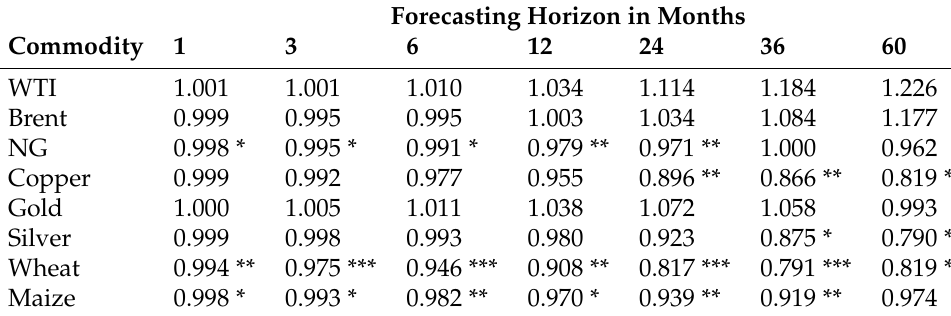
Table 3. RMSFE ratio for real commodity price LP-based forecasts.